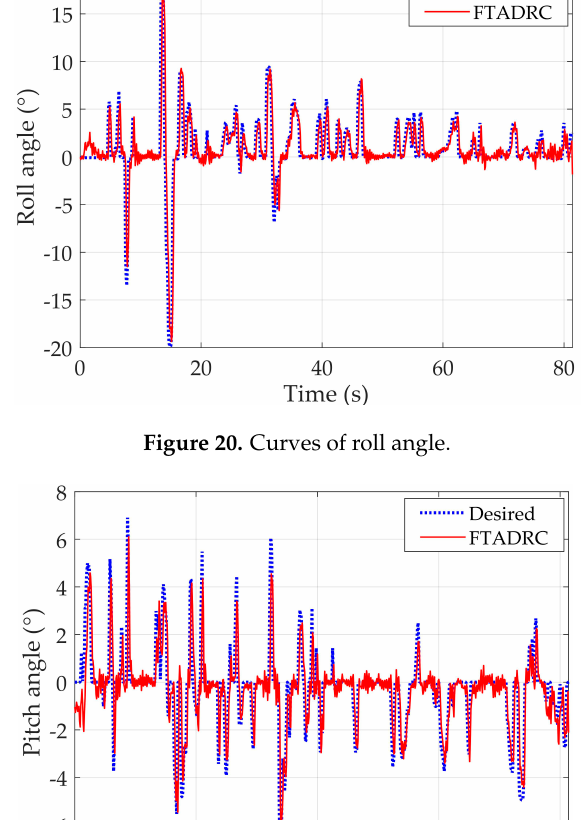
Figure 22. Curves of yaw angle.